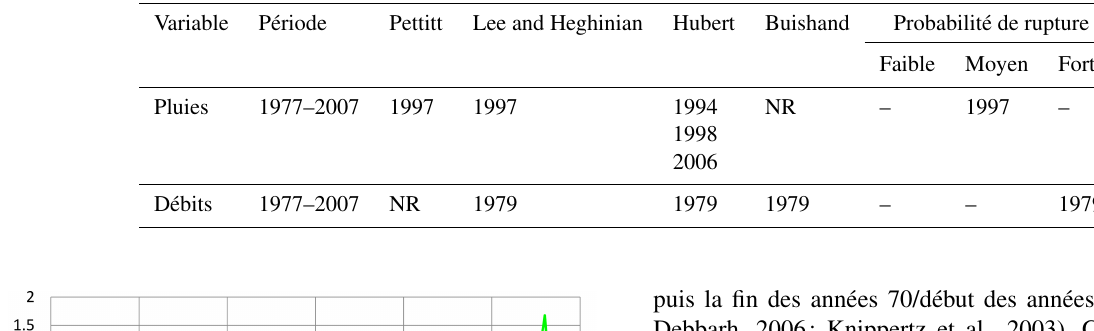
Tableau 1. Ruptures détectées par les tests de KhronoStat pour les séries de pluies et débits moyennes sur le bassin versant du Bouregreg, période 1977–2007. (NR = Pas de rupture).